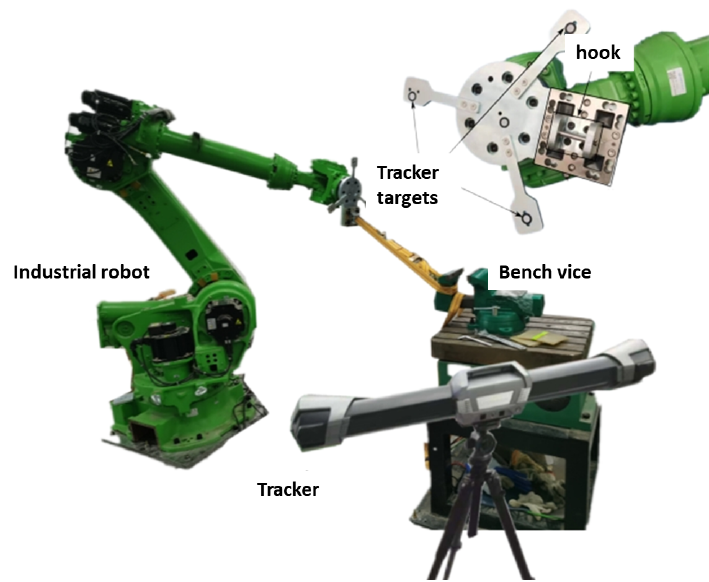
Figure 15. The platform of the stiffness